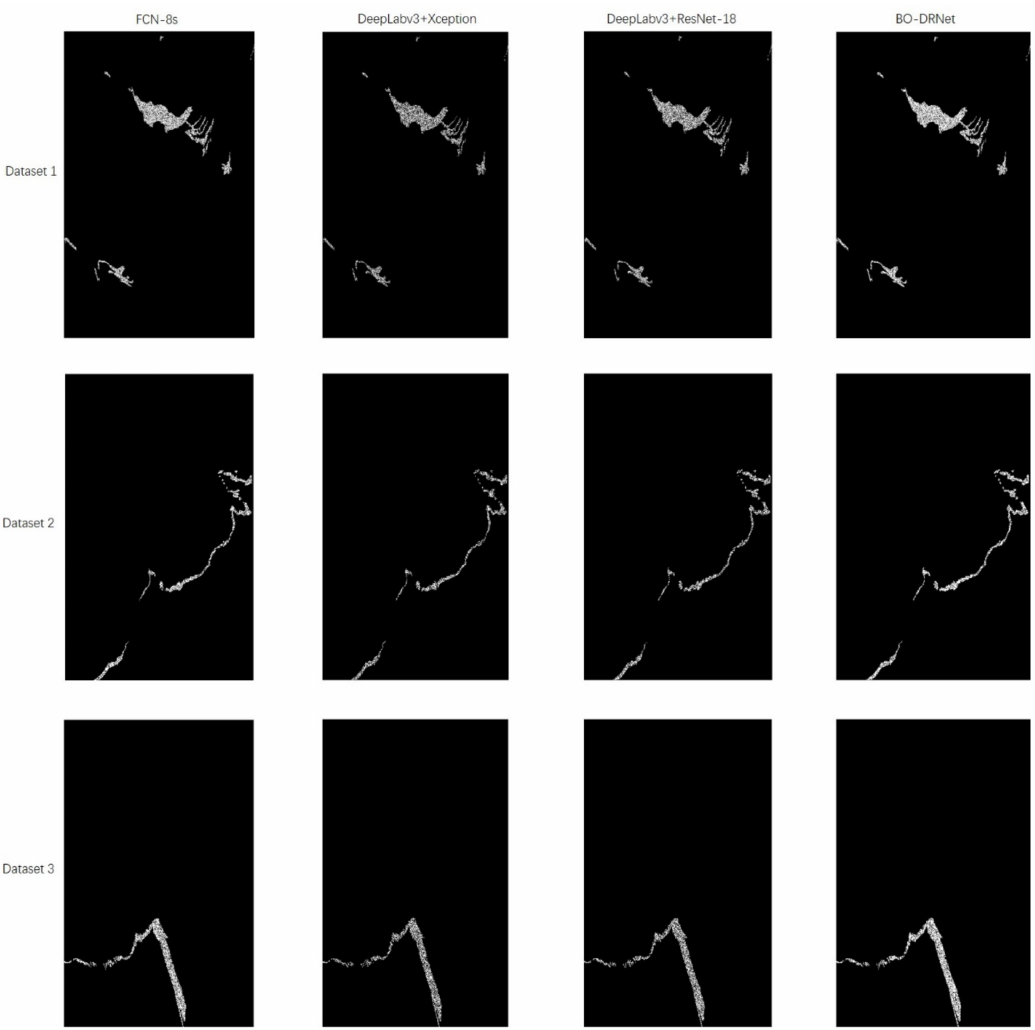
Figure 9. Binary images for three datasets are made according to the experimental results of four deep learning models. The first row is the binary images of dataset 1, the second row is the binary images of dataset 2, and the third row is the binary images of dataset 3. White represents oil spill pixels and black represents non-oil spill